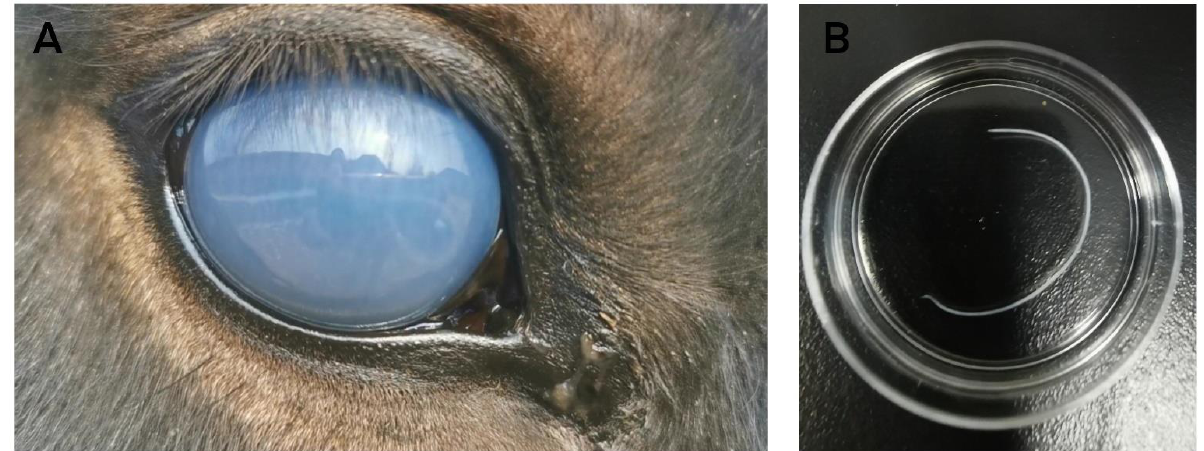
Figure 1. Corneal edema and ocular discharge in the right eye upon examination ( A ). Extracted S. digitata worm from the eye ( B ).